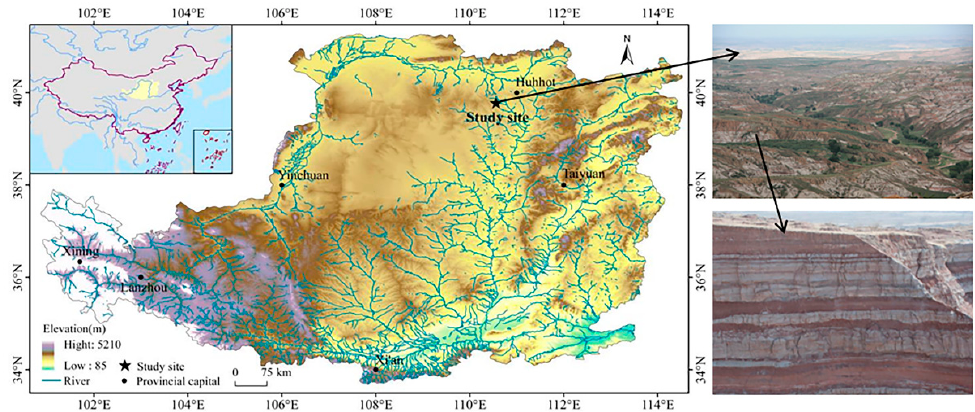
Figure 1. Geographical location of the study area and real images of sandstone covered with loess.